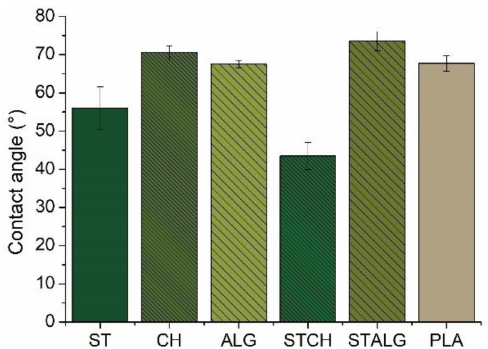
Figure 3. Contact angle of the starch-based (ST), chitosan-based (CH), alginate-based (ALG), starch and chitosan-based (STCH) and starch and alginate-based (STALG) films and the commercially available PLA-based film ( p <